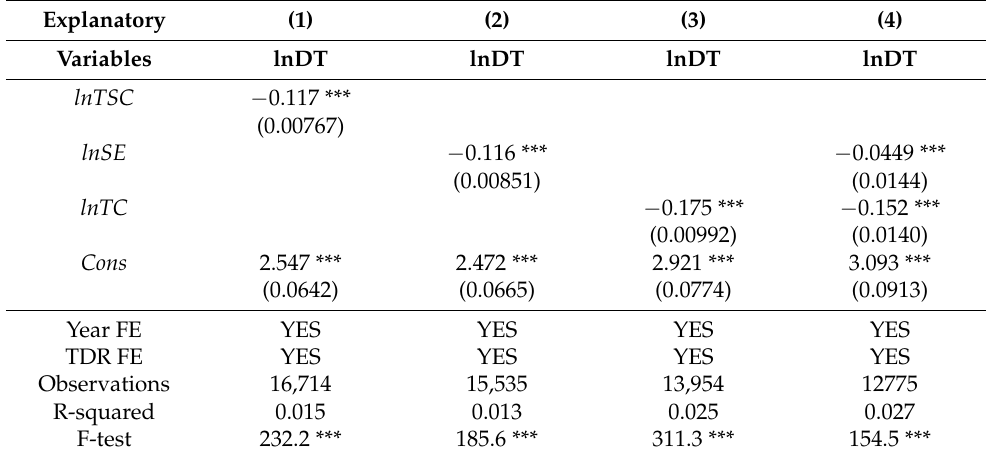
Table 5. TSC effect of HSR on destination development (4